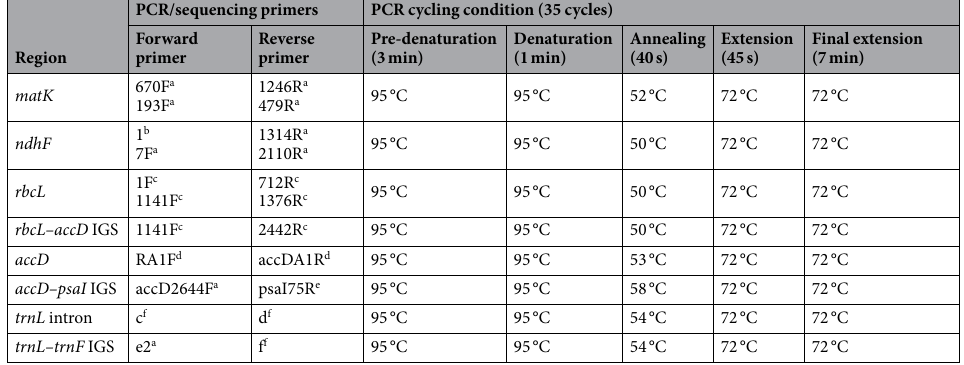
Table 2. PCR/sequencing primers and PCR cycling conditions for eight cpDNA regions examined in this study. Primer names follow the original publications. a Present study; b Olmstead and Sweere 52 ; c Yasui and Ohnishi 53 ; d Inamura et al . 40 ; e Shaw et al . 54 ; f Taberlet et al . 55